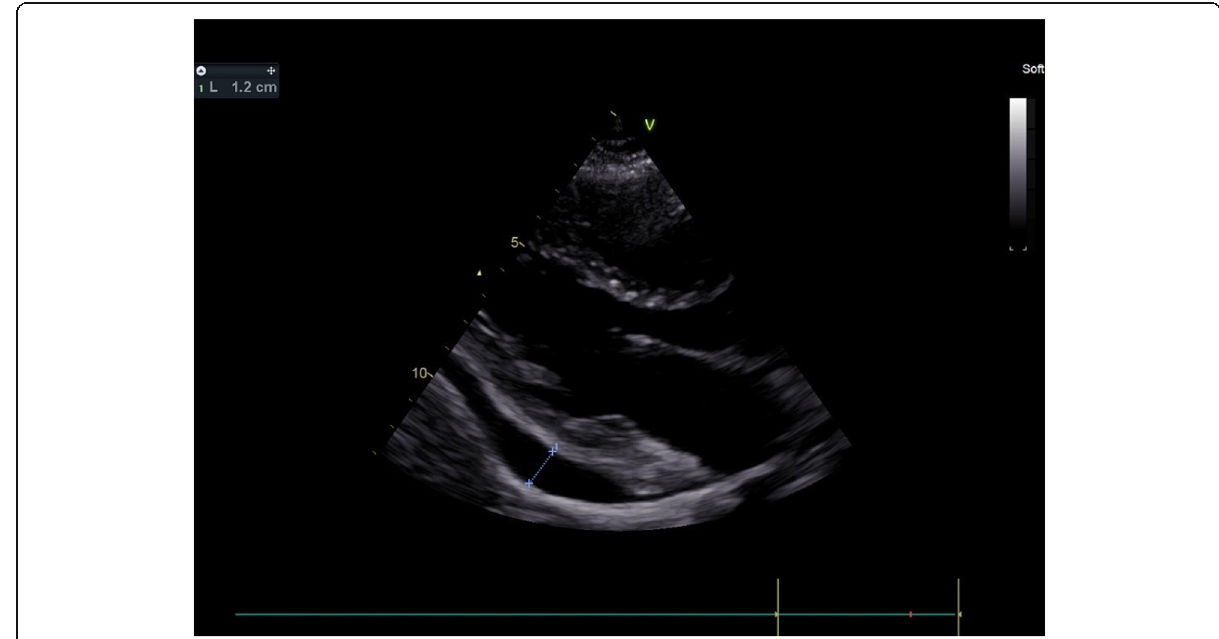
Fig. 4 Mild to moderate PE in the second patient was detected by TTE